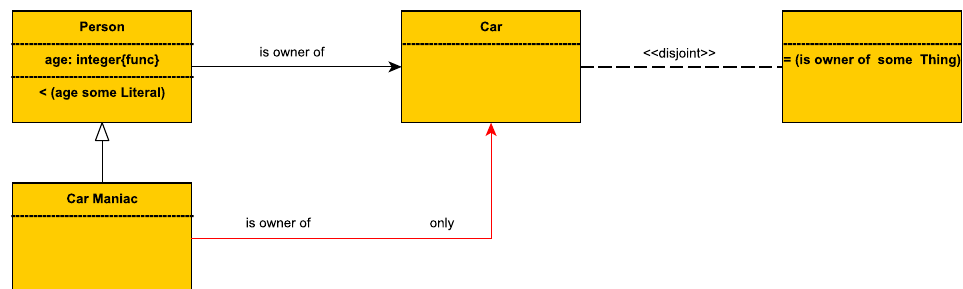
Figure 8. Example of a small ontology in G RAPHOL .